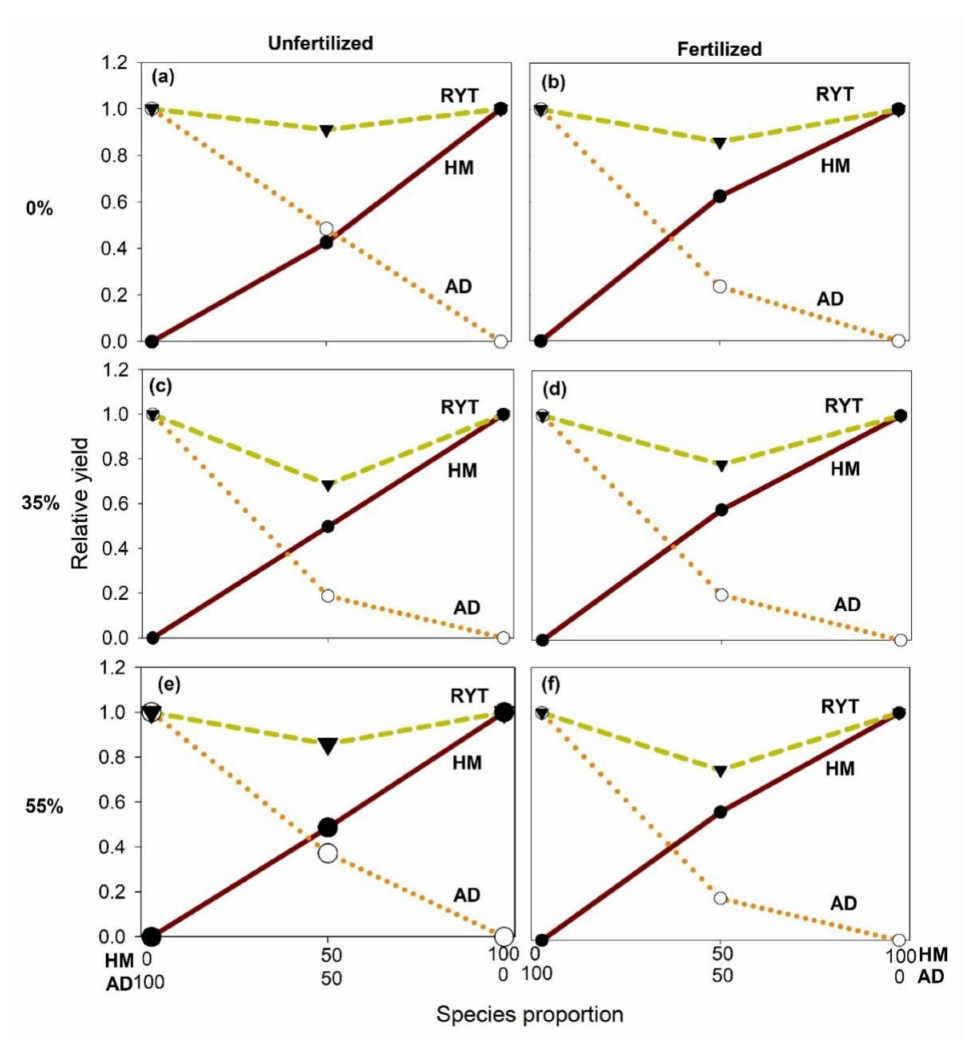
Figure 3. Relative yield total (RYT) of unfertilized and fertilized Heracleum moellendorffii . (HM) and Adenophora divaricata (AD) in 0% ( a , b ), 35% ( c , d ), and 55% ( e , f ) shade treatments. A significant effect of interaction between shade and planting method on belowground biomass of A. divaricata , particularly those grown in a low soil moisture condition, was detected (Figure 5; Table S2). Belowground biomass growth was generally higher in the monoculture plot at full sunlight and 55% shade condition, compared with that in 35%